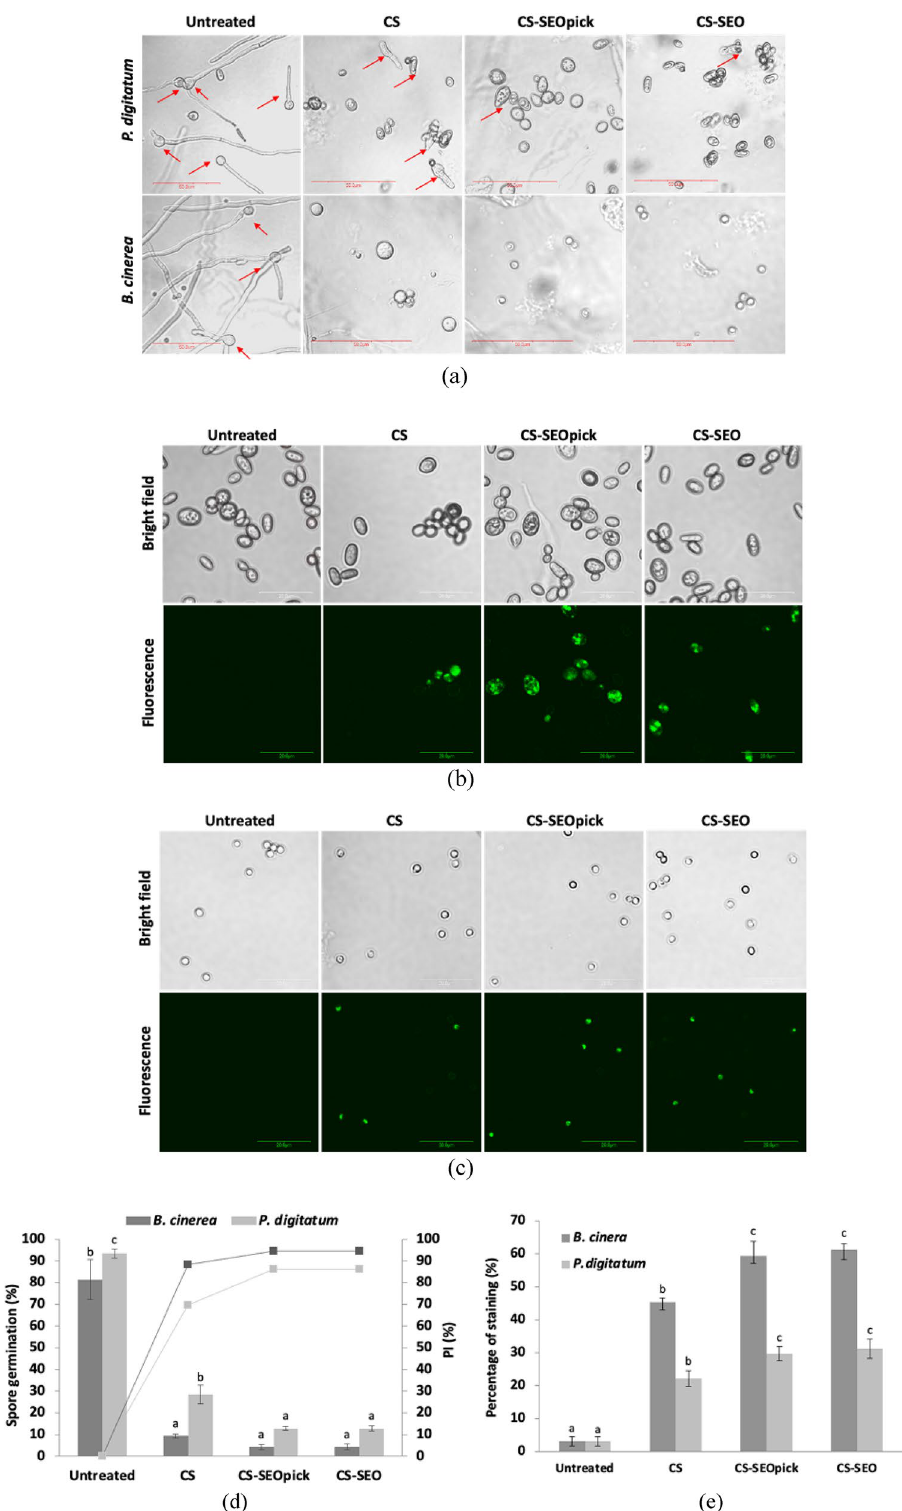
Figure 4. Effect of coating treatment for the decrease in spore survival of P. digitatum and B. cinerea visually ( a ) and statistically ( d ). Detection of membrane integrity visually of P. digitatum ( b ), B. cinerea ( c ), and statistically ( e ). Different letters indicate statistically significant differences among different treatments at P < 0.05. CS chitosan, CS-SEOpick chitosan–sandalwood oil Pickering emulsion, CS-SEO chitosan–sandalwood oil regular emulsion treated